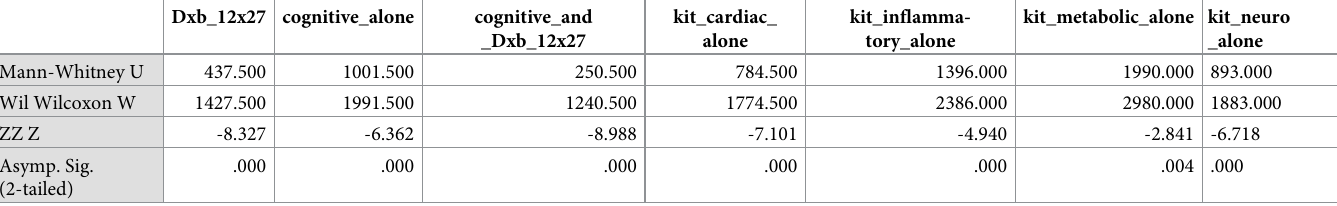
Table 5. Statistics for plasma features alone & cognitive alone and paired with best plasma feature.